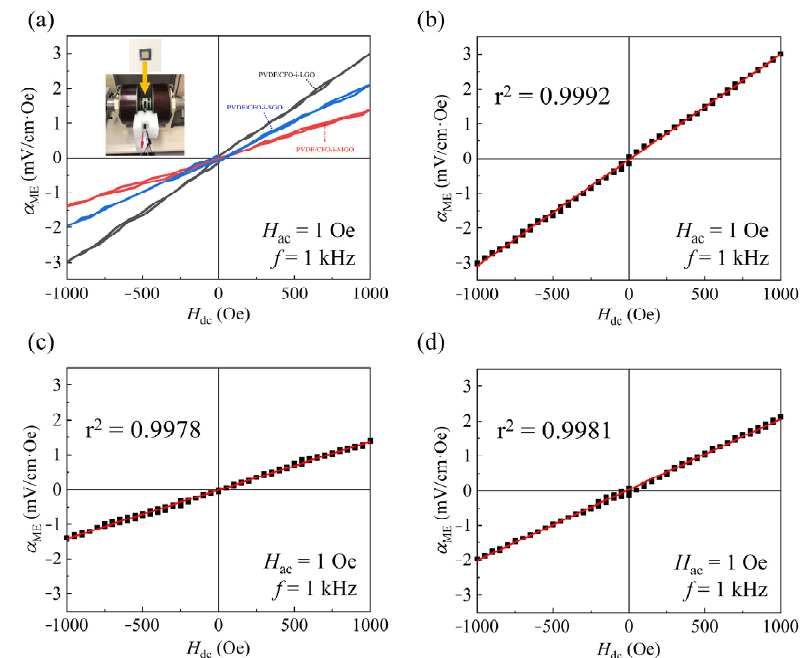
Figure 10. ( a ) Comparison of the ME responses in the 3-2 type ME films of